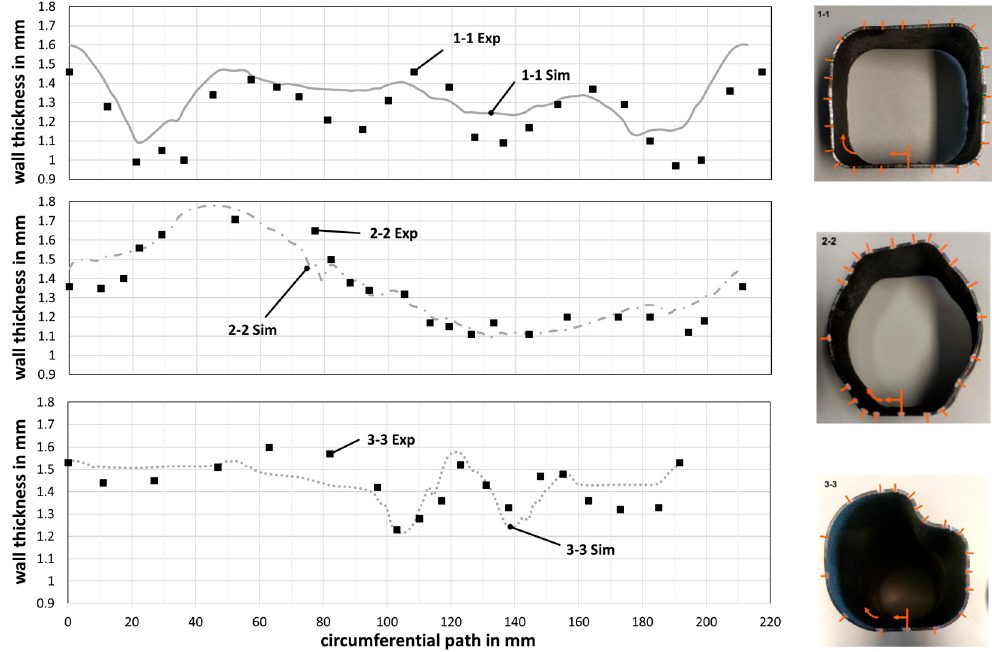
Figure 10. Wall thickness validation for the three sections, experiment (Exp) and simulation (Sim).